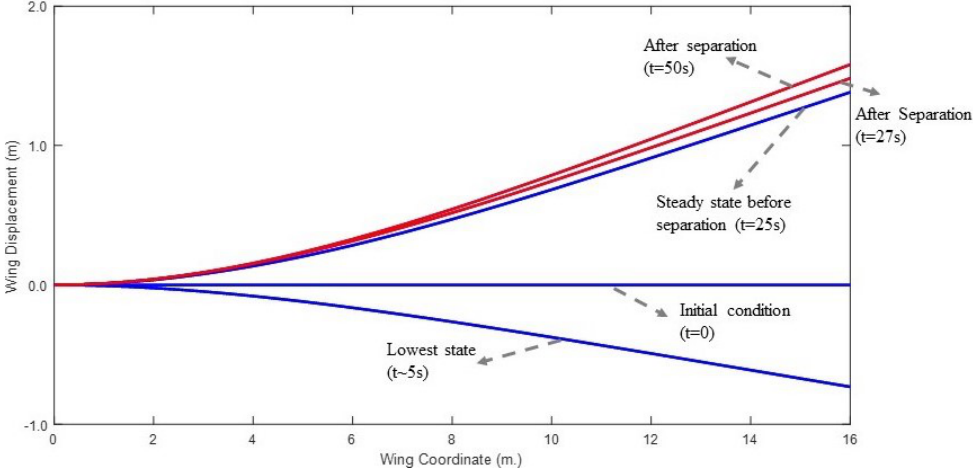
Figure 8. Displacement shape of the wing at different times.